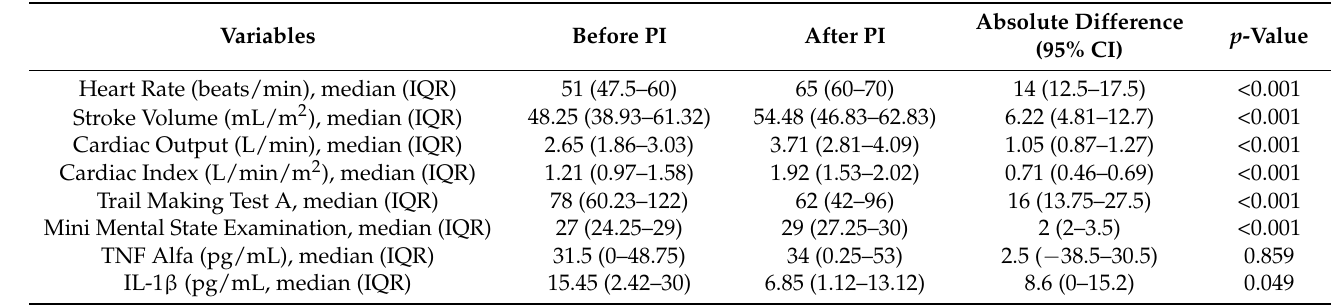
Table 2. Characteristics in dynamics.